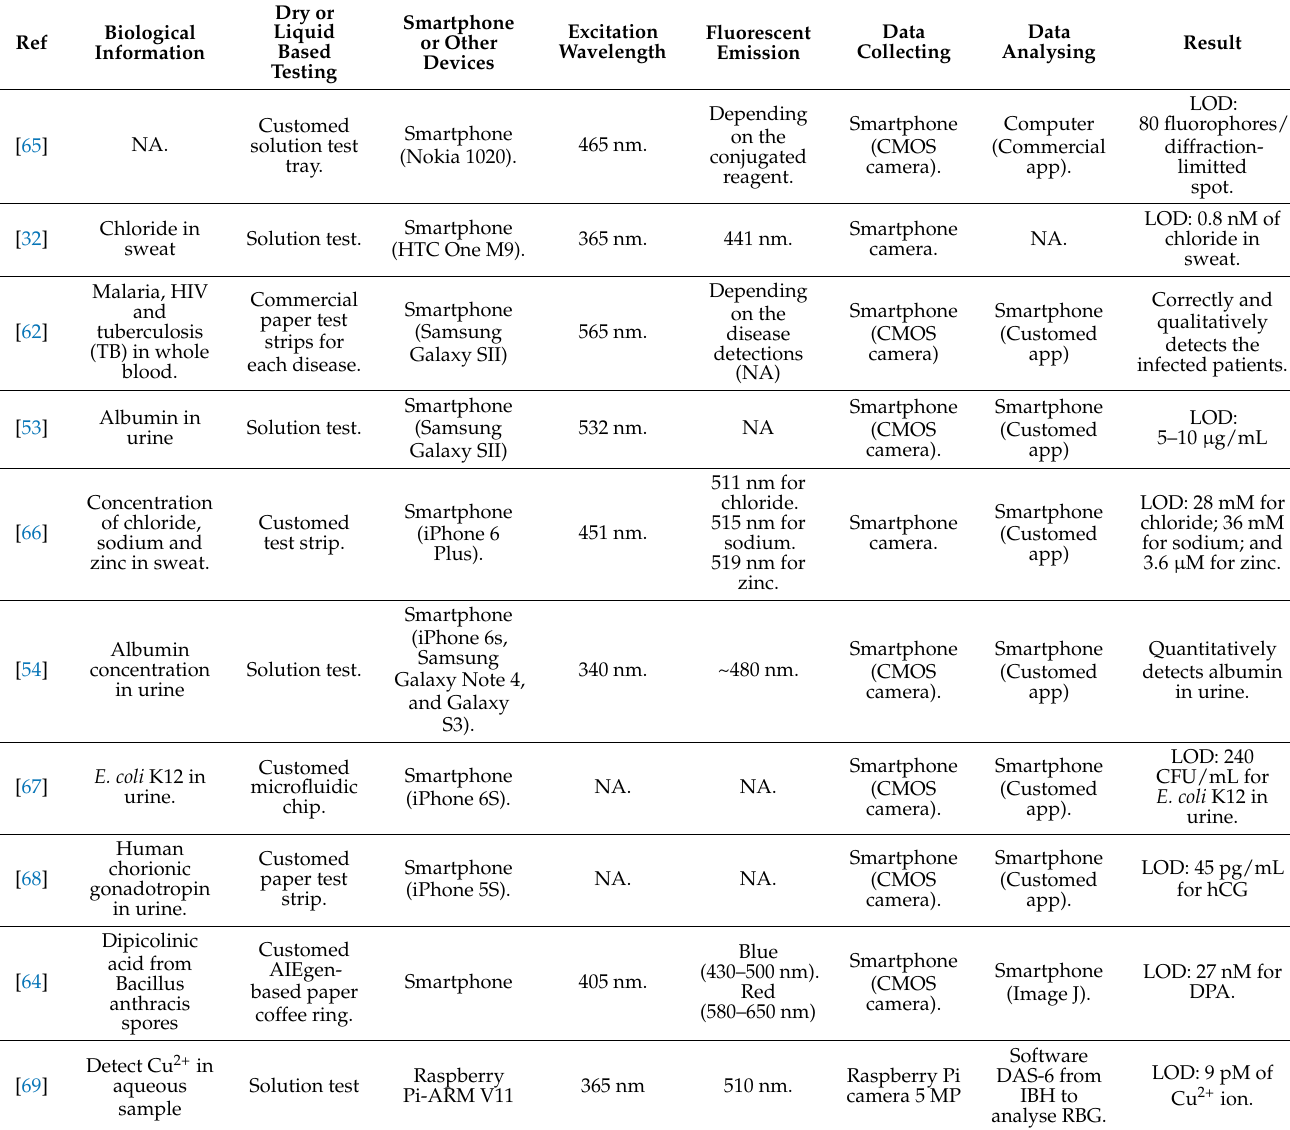
Table 5. Portable devices using the fluorescence method to detect biomarkers in body